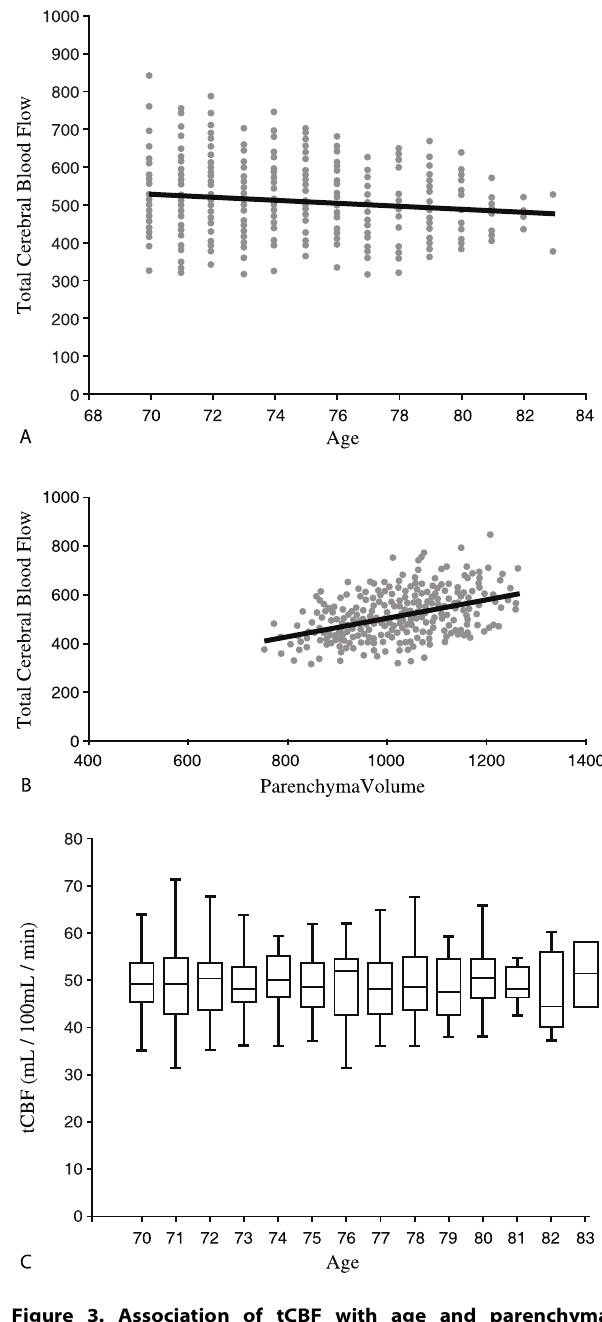
Figure 3. Association of tCBF with age and parenchyma volume. Scatterplot of tCBF (mL/sec) versus age (yrs) ( r =–.124; p =0.008) ( a ) and parenchymal volume (mL) ( r =0.430; p # .001) ( b ). Box-and-whisker plot of average tCBF (mL/100 mL/min) found for each age (yrs) ( c ).